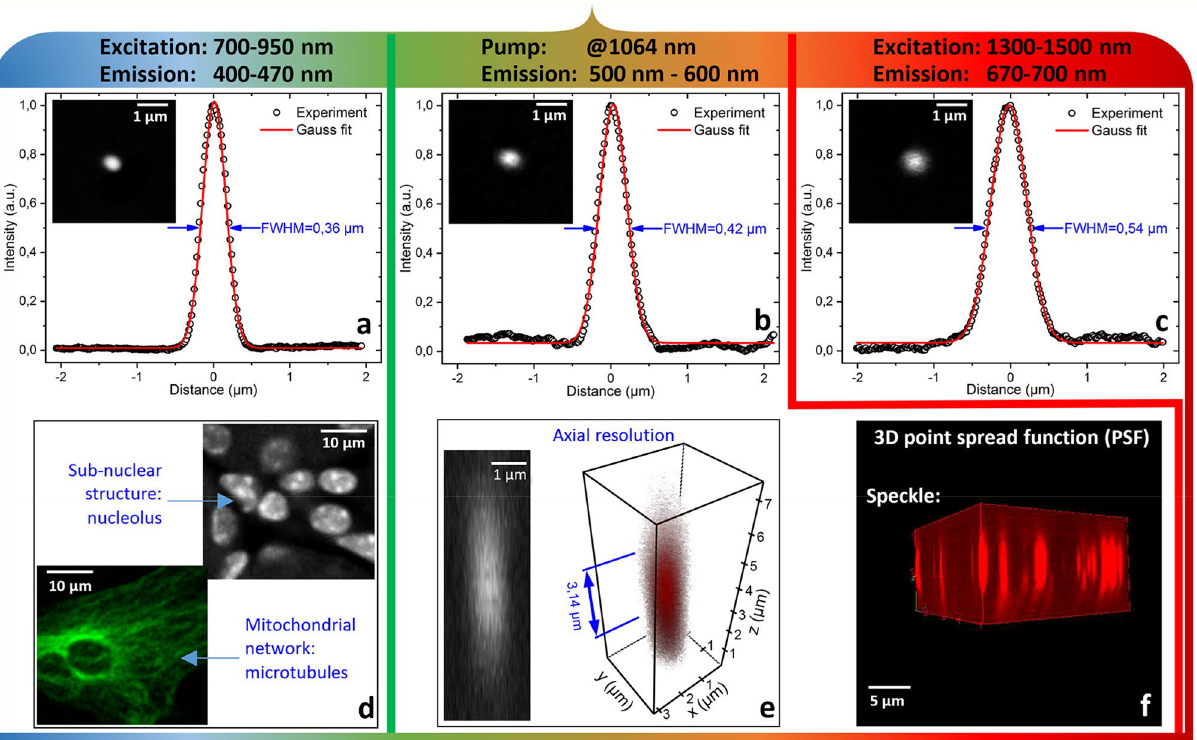
Figure 4. Measure of the spatial resolution of our fluorescence imaging microscopy system, based on 2PA, for three different wavelength domains. Lateral resolution in the range of 700–950 nm ( a ), 1300–1500 nm ( c ) and for 1064 nm only ( b ). ( d ) Example of high-resolution images, showing sub-nuclear structure (nucleolus) and microtubules. ( e ) Axial resolution at the pump wavelength. ( f ) 3D PSF for a speckled beam at 1064